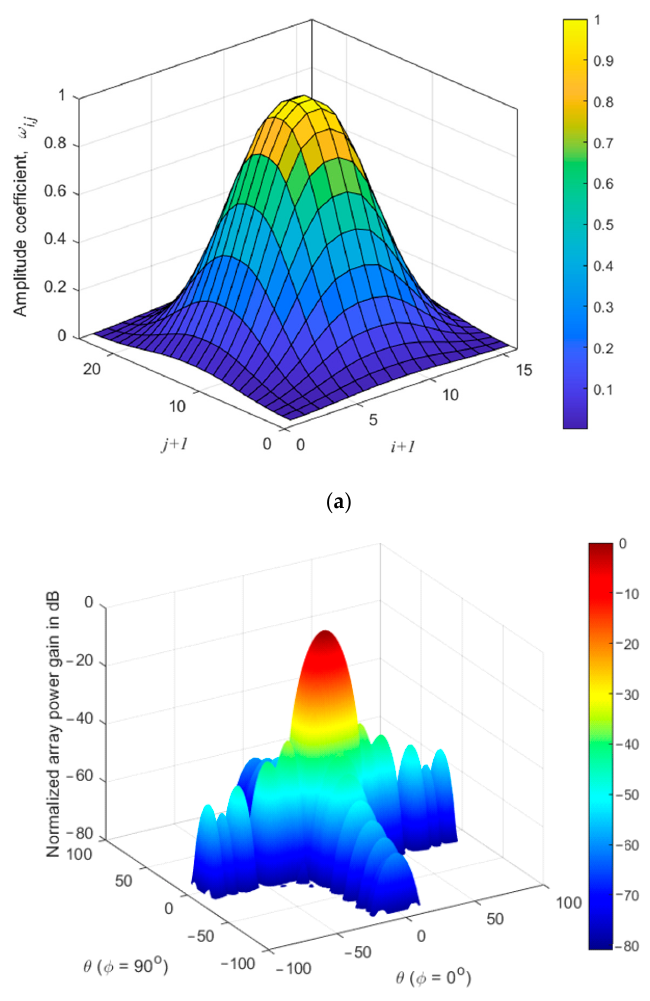
Figure 13. ( a ) 2D cross-linear extrapolated cosine-square window for 16 × 24 array. ( b ) Normalized array power pattern.